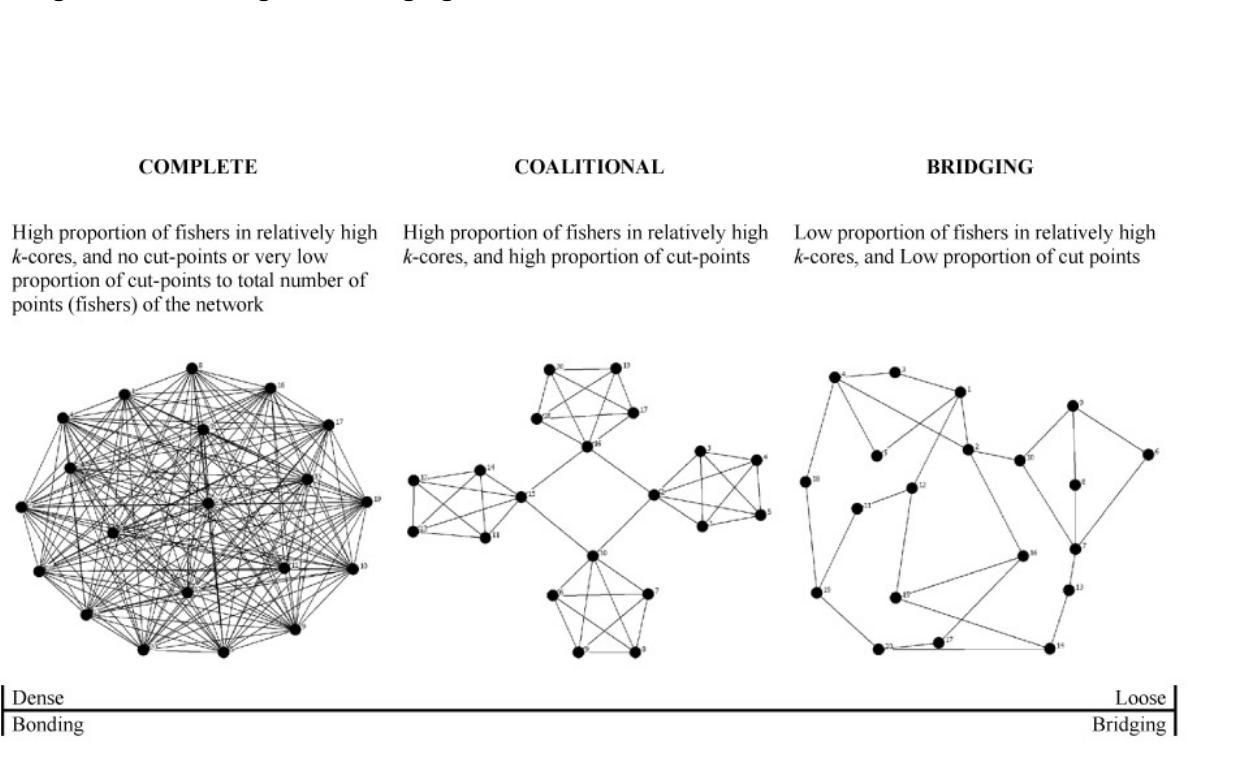
Fig. 2. Description of three network structures according to k -cores and cut-points network metrics along a dense-bonding/loose-bridging